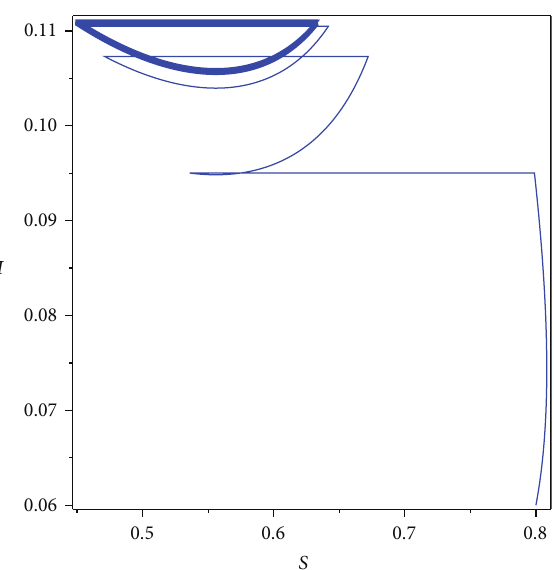
Figure 7: Phase diagram of system (42) while 𝜃 = 0.9 .